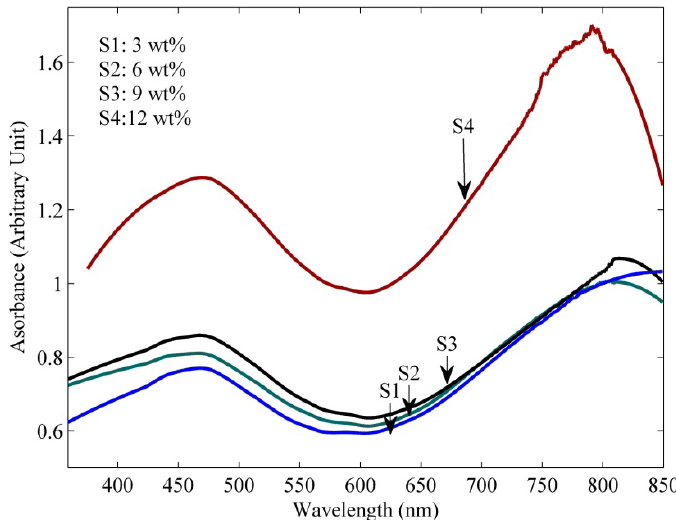
Figure 3. Absorbance spectrum of the PPy/MWNT for different MWNT (wt %) concentrations S1: 3 wt %; S2: 6 wt %; S3: 9 wt %; S4: 12 wt